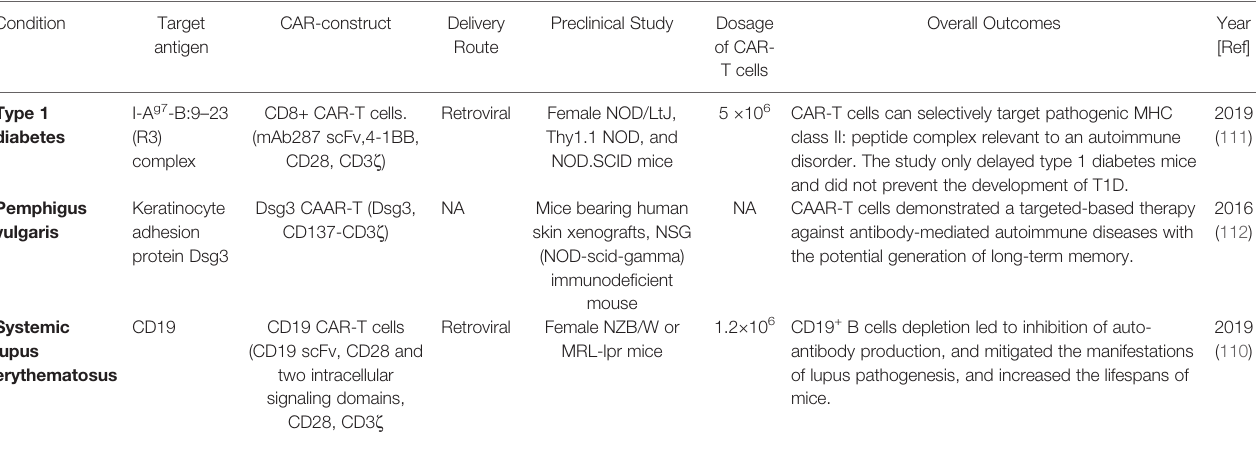
TABLE 2 | CAR-T-based therapy in preclinical models of autoimmune diseases.